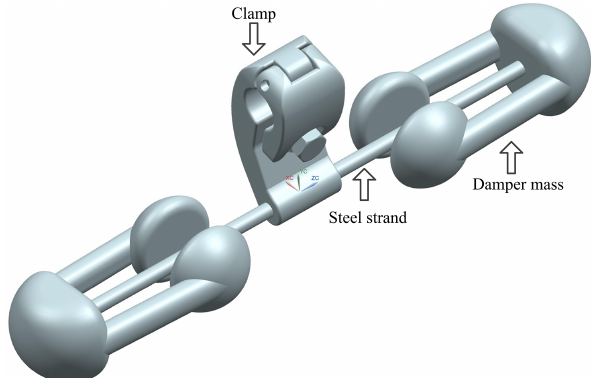
Figure 1. Three-dimensional model of the Stockbridge type vibra- tion